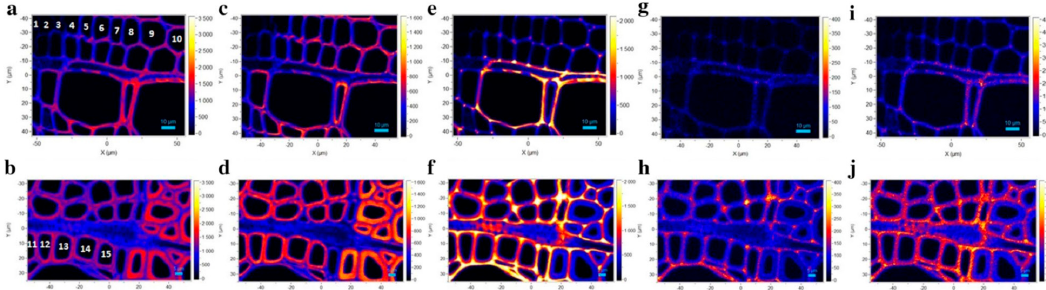
Figure 5. Raman images of xylem for poplar wood calculated by integrating from 2800 to 3030 cm − 1 ( a , b overall morphology), from 2800 to 2918 cm − 1 ( c , d carbohydrates), from 1540 to 1700 cm − 1 ( e , f , lignin), from 1255 to 1290 cm − 1 ( g , h G units), and from 1320 to 1338 cm − 1 ( i , j , S units). Images a , c , e , g , i : xylem near the cambium and images b , d , f , h , j xylem near the annual ring (AR). Reproduced with permission from Ref. [59]. Copyright SPRINGER NATURE 2018.